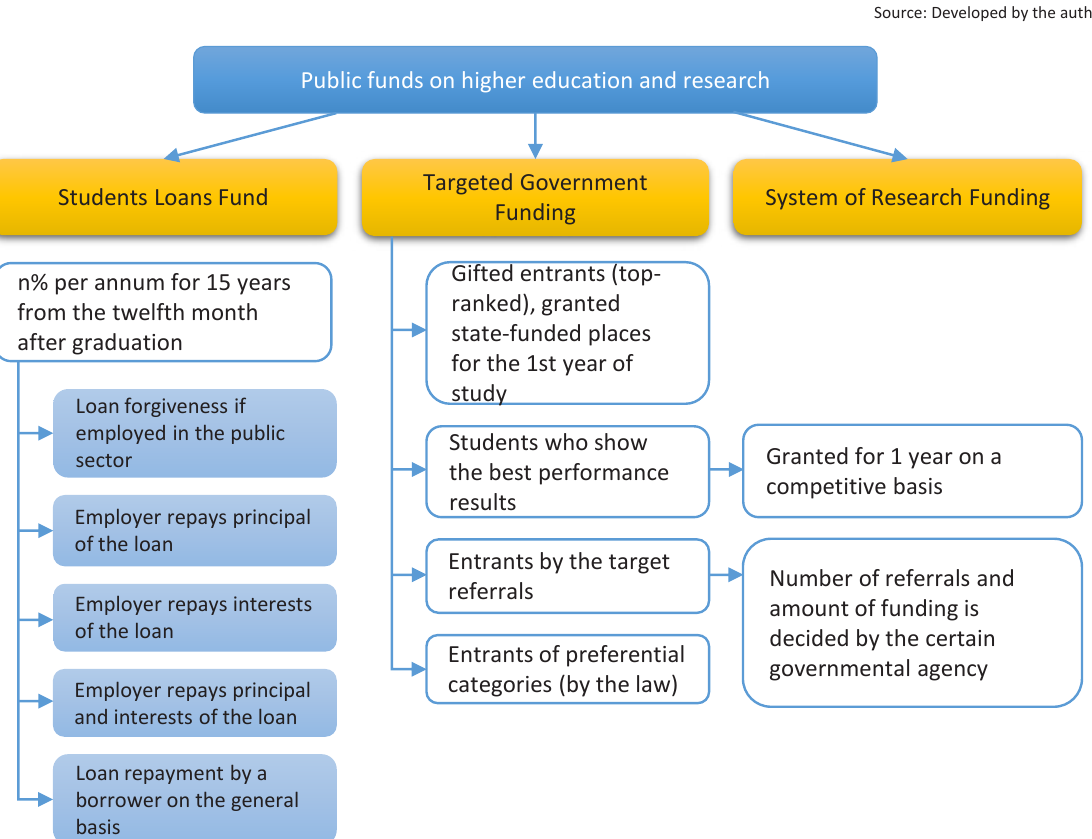
Figure 4. Mechanism of public higher education funding in Ukraine: authors’